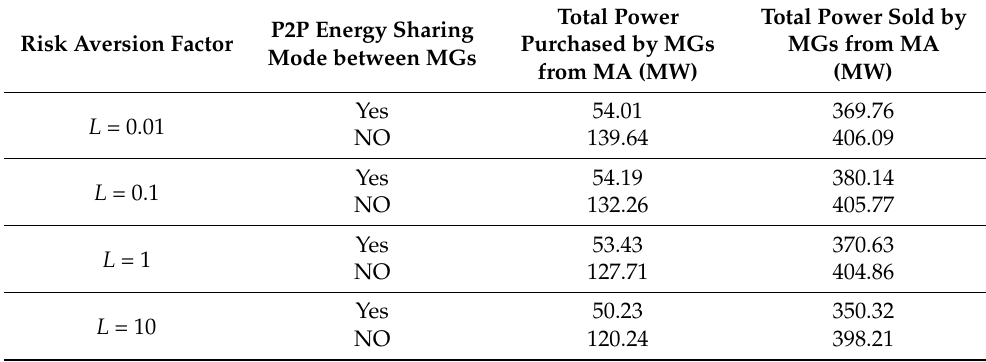
Table 3. Electric energy trading quantity of MGs and MA with different risk aversion factors. Risk Aversion